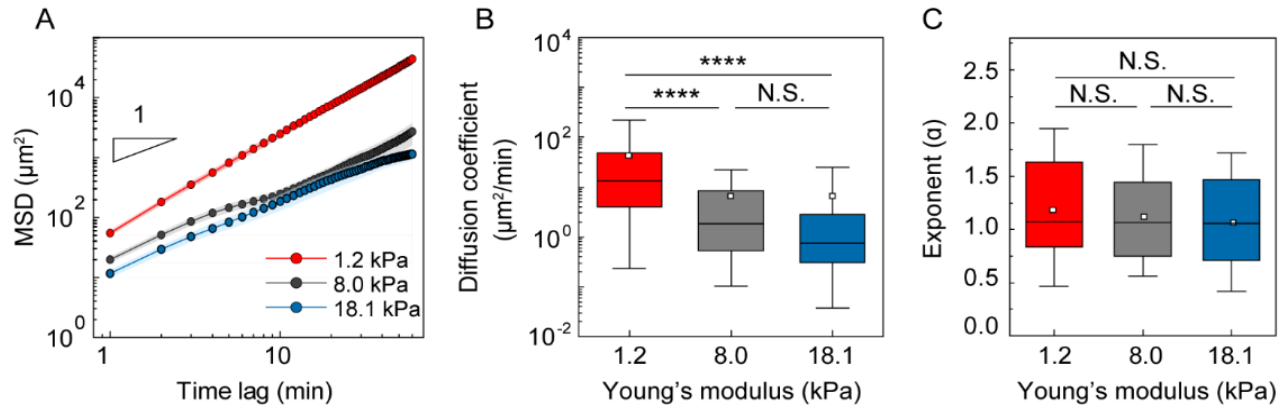
Figure 3. Statistical analysis of DC motility under different mechanical loads. ( A ) MSD was plotted to demonstrate the persistent random motion of DCs. Lines indicate the mean value of MSD from three independent experiments and error bars represent S.E. ( B ) Diffusion coefficient, ( C ) exponent alpha, α , pooled from three independent biological replicates. Kruskal–Wallis/Dunn’s multiple comparisons test used for comparisons of different sample populations; ****: p < 0.0001, N.S.: p > 0.05. In the box plots, the bars include 95% of the data, the box contains 75% of the data, the center bar corresponds to the median and the square point represent the mean. Data were pooled from three independent biological replicates.